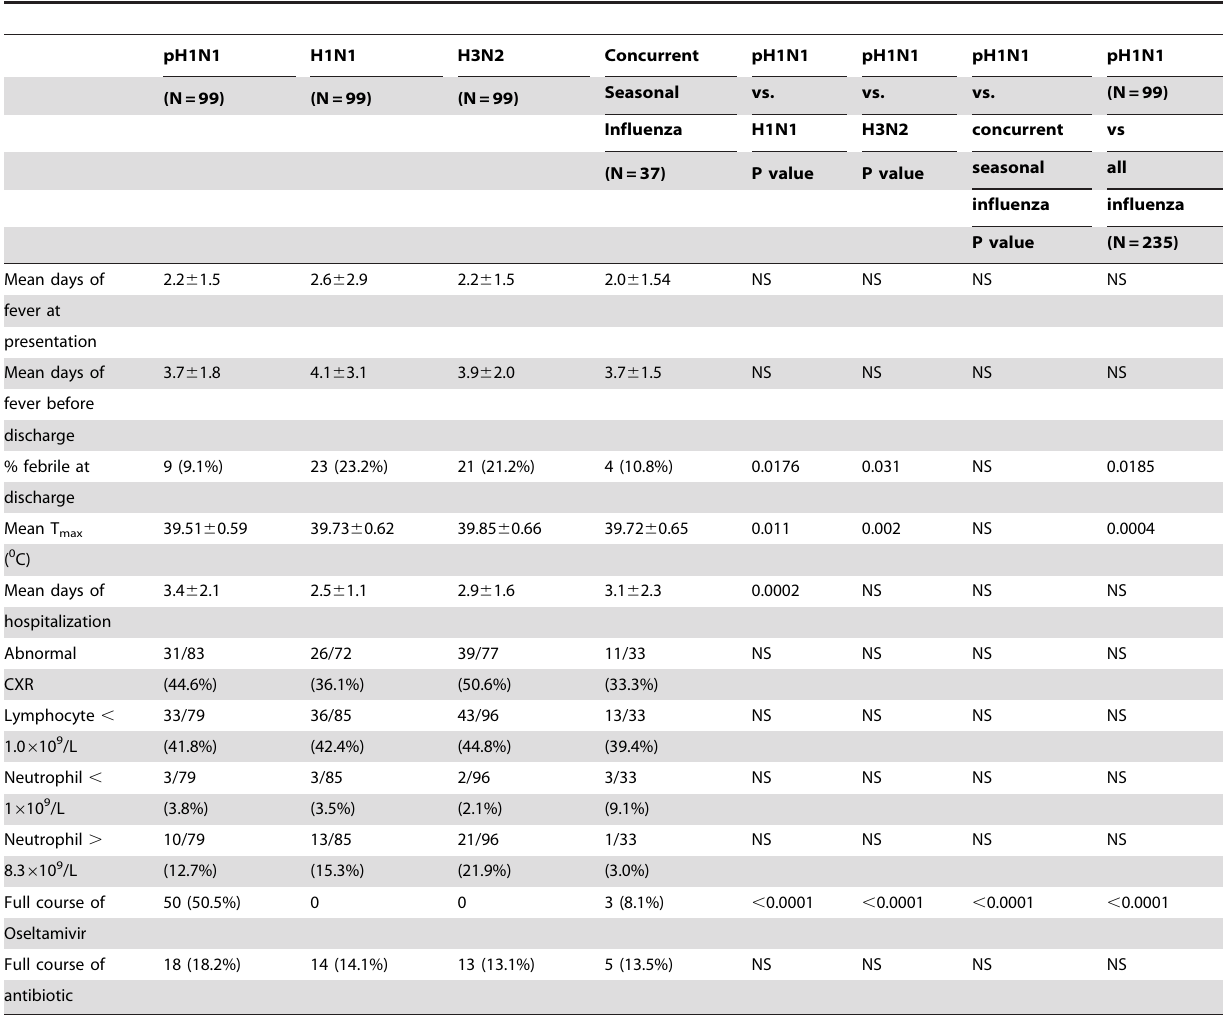
Table 3. Comparison of duration of fever, investigation results and treatment of children hospitalized for influenza A pH1N1 with age- matched controls hospitalized for seasonal H1N1 and H3N2, and with children hospitalized for seasonal influenza concurrently during the study period,